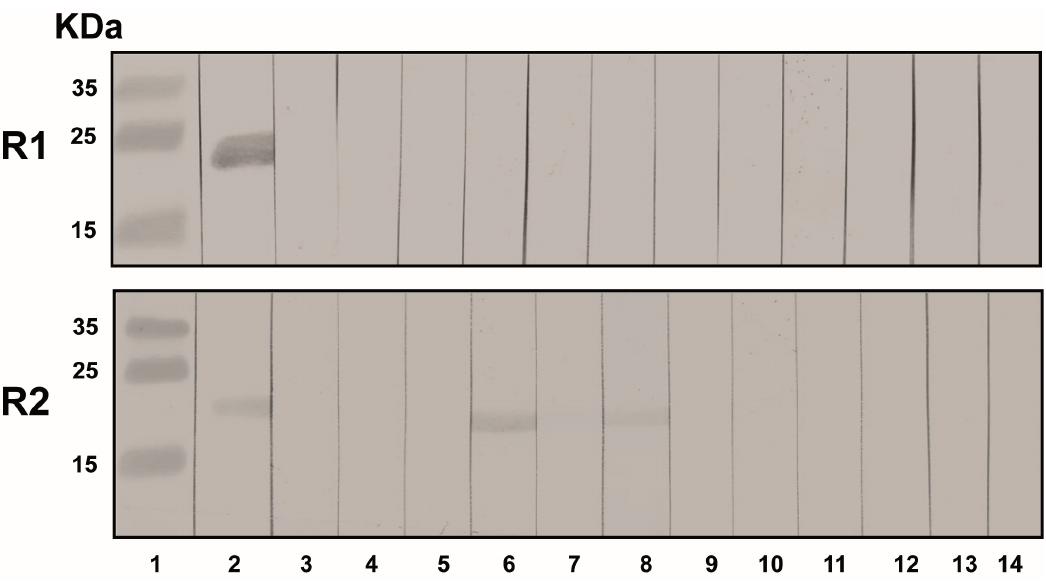
Figure 2. Western blot analysis of sera from humans working as butchers or in the meat industry using the R1 and R2 recombinant protein of glycoprotein B (gB) of PCMV. Anti-His serum was used as a positive control (lane 2). Anti-His serum was used at a dilution of 1:1000, human sera at 1:300, and anti-human serum at 1:1000. Lane 1, marker proteins, lane 2, antibodies against the His tag, lane 4 to 14, different human sera samples.